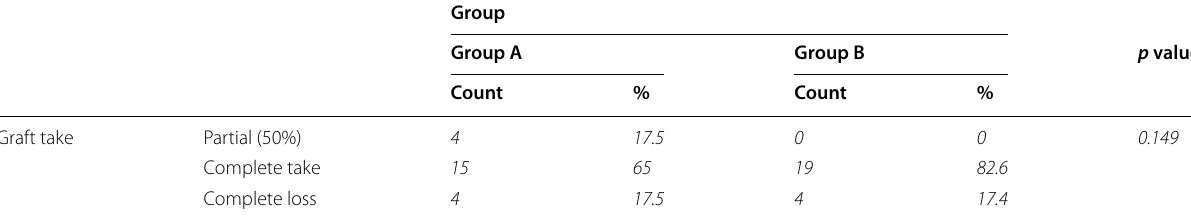
Table 1 Comparison between tympanic membrane healing results in both groups